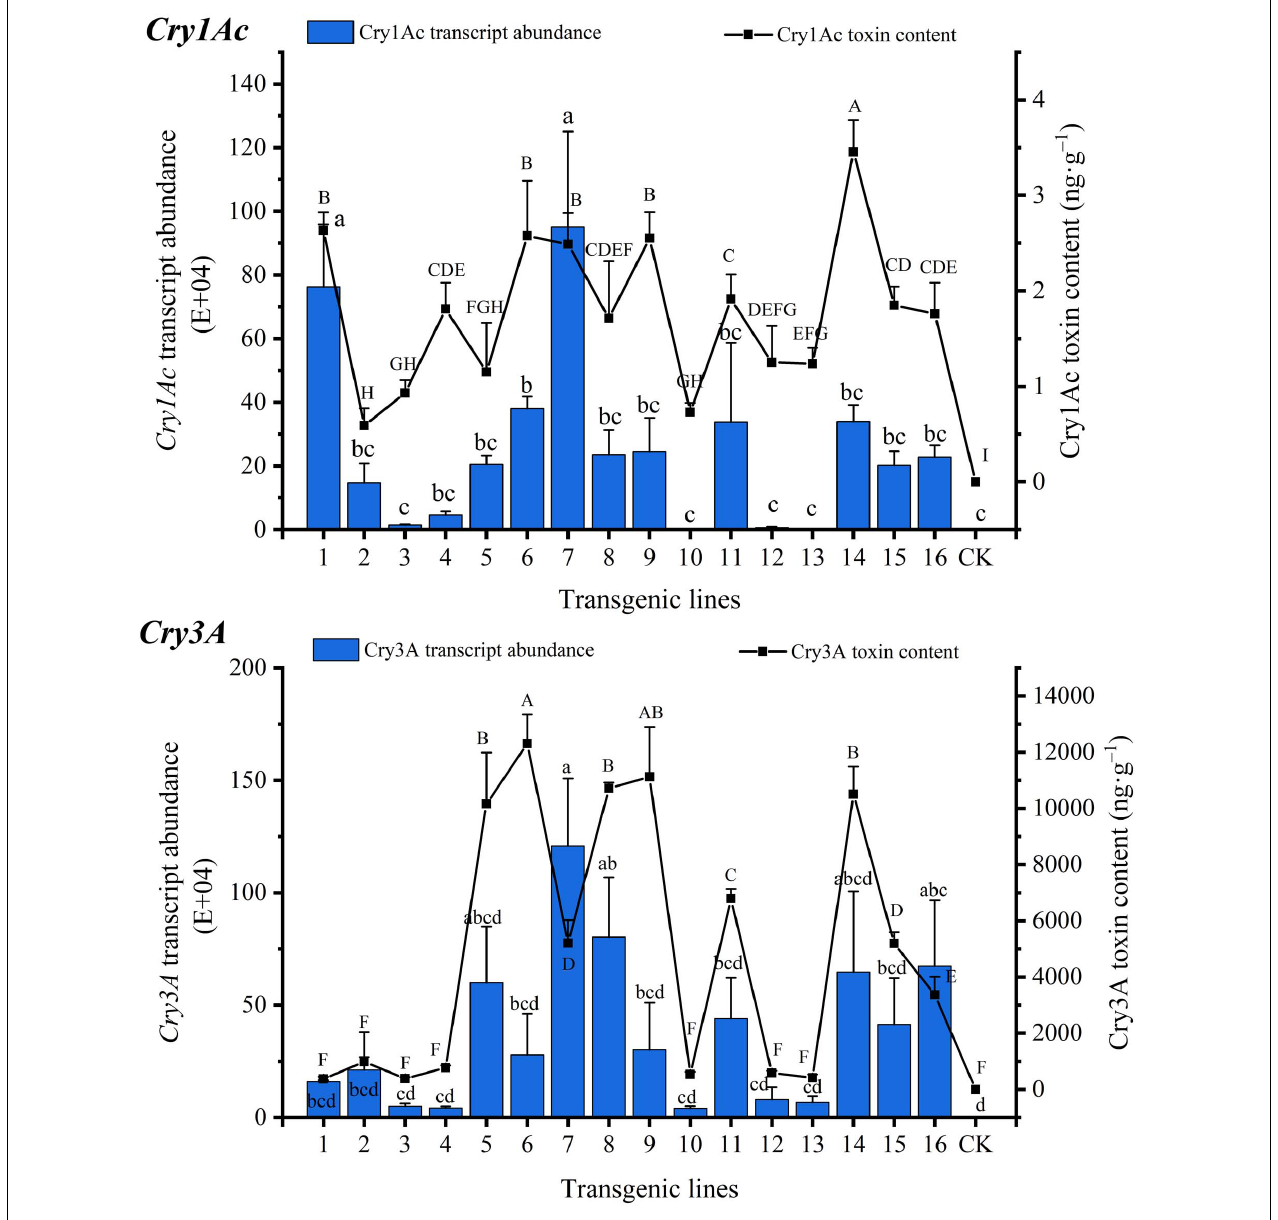
FIGURE 2 | Transgene transcript abundance and Bt toxin protein content in transgenic lines. Lowercase letters indicate multiple comparisons of the transcript abundance of the transgenic lines ( P < 0.05), and capital letters indicate multiple comparisons of the Bt toxin protein contents of the transgenic lines ( P <